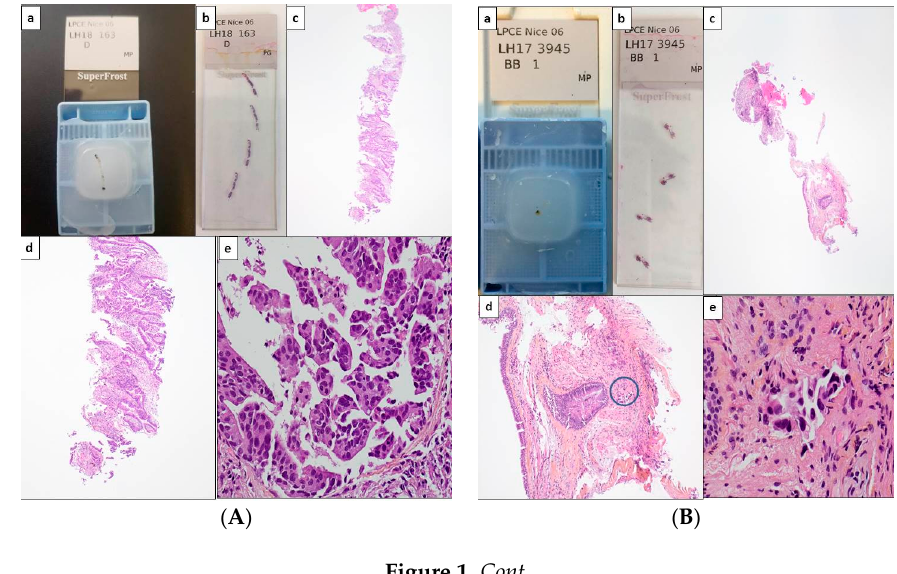
Figure 1. Cont. Figure 1.